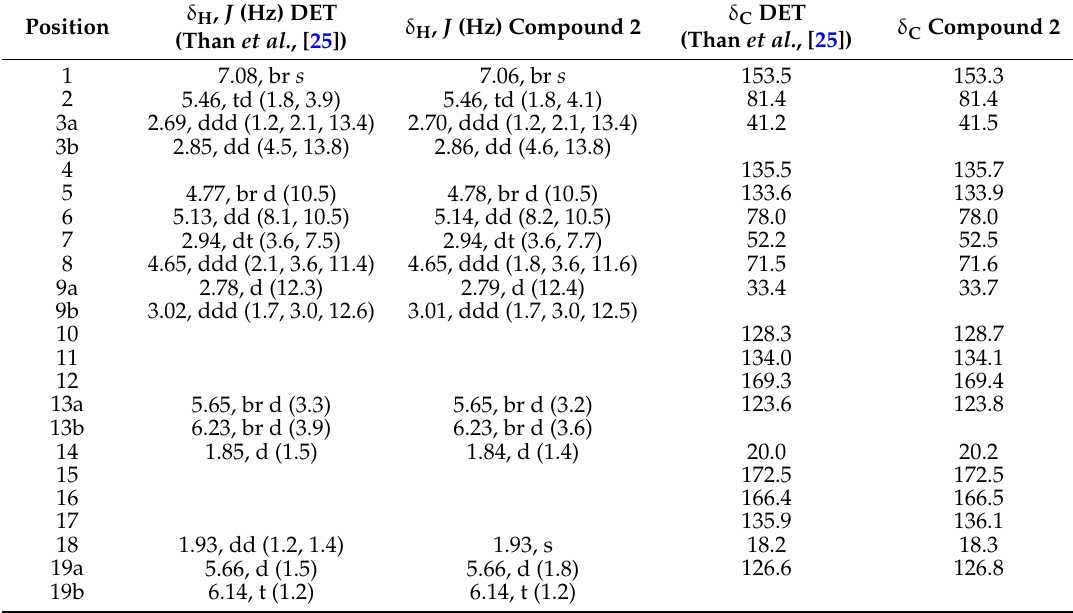
Table 2. Comparison of the 1 H- and 13 C-NMR of DET and 2 ( δ in ppm; 400 MHz in CDCl 3 ). Position